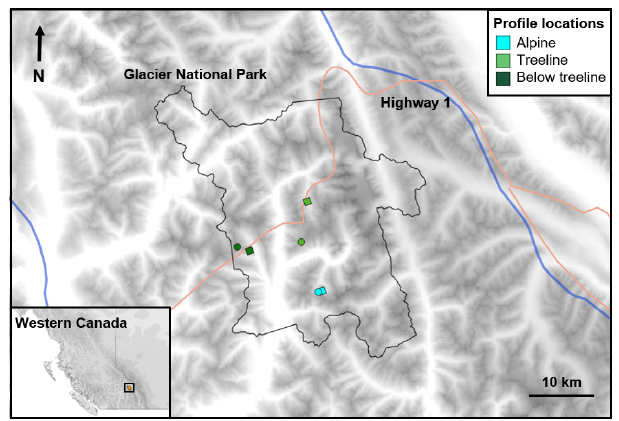
Figure 1. Location of Glacier National Park in western Canada. Weather and snowpack data were generated with numerical weather prediction and physical snow cover models for each elevation band. The locations of the grid points used for each elevation band